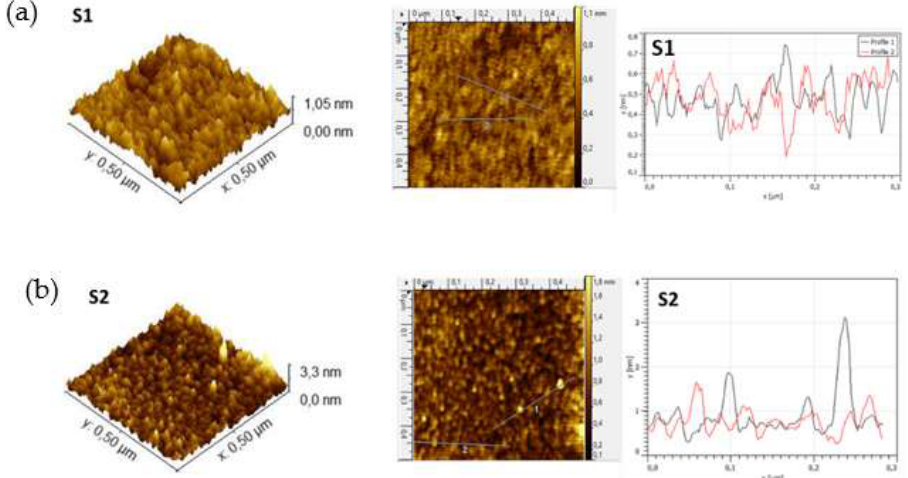
Figure 2. 3D and 2D surface topography images of the TiO 2 thin films deposited on glass, and profiles extracted along two different arbitrary lines on the surface at ( a ) 5 sccm (sample S1) and ( b ) 25 sccm (sample S2) Ar fluxes. Table 2. Average roughness Ra, root-mean-square RMS, and image surface area difference of the sputtered TiO 2 layers.